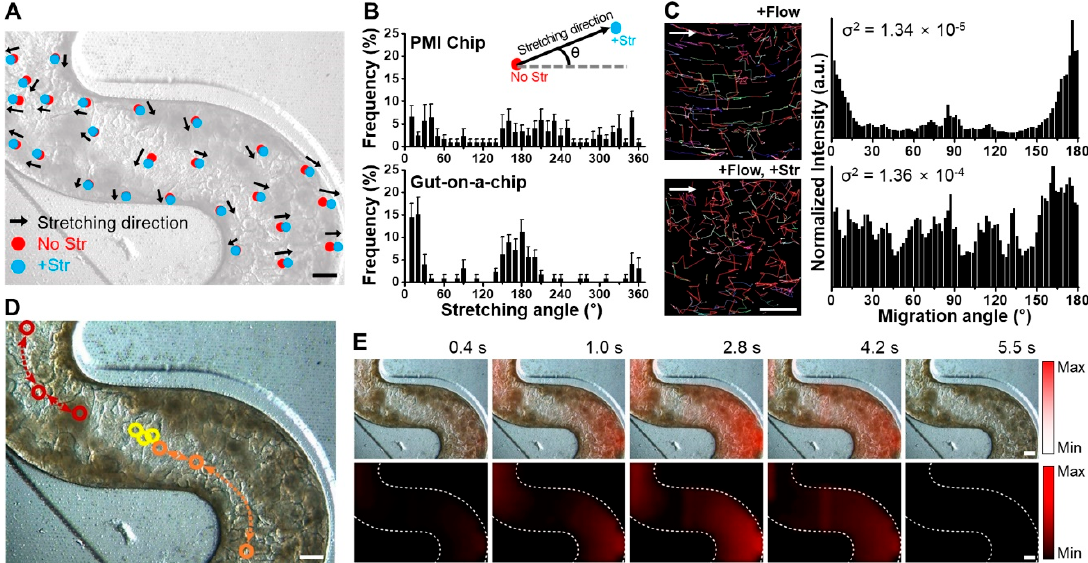
Figure 2. The visualization of multiaxial stretching motions in a PMI Chip. ( A ) A phase contrast micrograph of the normal organoid epithelium cultured in a PMI Chip for 8 days with rhythmical mechanical motions. Bar, 250 µm. The dynamic displacement of multiple locations in the microchannel was tracked without (0% strain, No Str) or with stretching motions (5% cell strain, +Str), where the arrows indicate the direction of stretching. The magnitude of elongation was reflected in the corresponding length of each arrow. The image was adjusted in gray to visualize the multiaxial stretching motions marked by dots and arrows. ( B ) The quantitative profiling of stretching directions as a function of orientation angle in a PMI Chip and a gut-on-a-chip. The PMI Chip shows omnidirectional uniform deformations compared to the gut-on-a-chip. ( C ) The trajectory of fluorescent beads (1 µm in diameter) introduced in the upper microchannel of a PMI Chip under the microfluidic flow alone (+Flow) or the presence of both flow and mechanical deformations (+Flow, +Str). Bar, 100 µm. The corresponding normalized histograms (right panel) quantitatively display the directional movement of randomly selected fluorescent beads (more than 65 particles) in the microchannel of a PMI Chip ( σ 2 , variance). ( D ) The tracking of three floating cells (red, yellow, and orange) in response to multiaxial deformations in a cycle of stretching motion in a PMI Chip. Bar, 250 µm. Open circles and dashed arrows indicate the location and trajectory of a target drifting particle, respectively. ( E ) The consecutive time-lapse images of the epithelial layer overlaid with the elongation map that visually highlights a cycle of elongation as a function of color density in a PMI Chip (upper) and a separated channel that independently shows the real-time quantification of the cell elongation in red (lower). The color bars indicate the minimum and maximum intensity of the elongation. Bars, 250 µm.